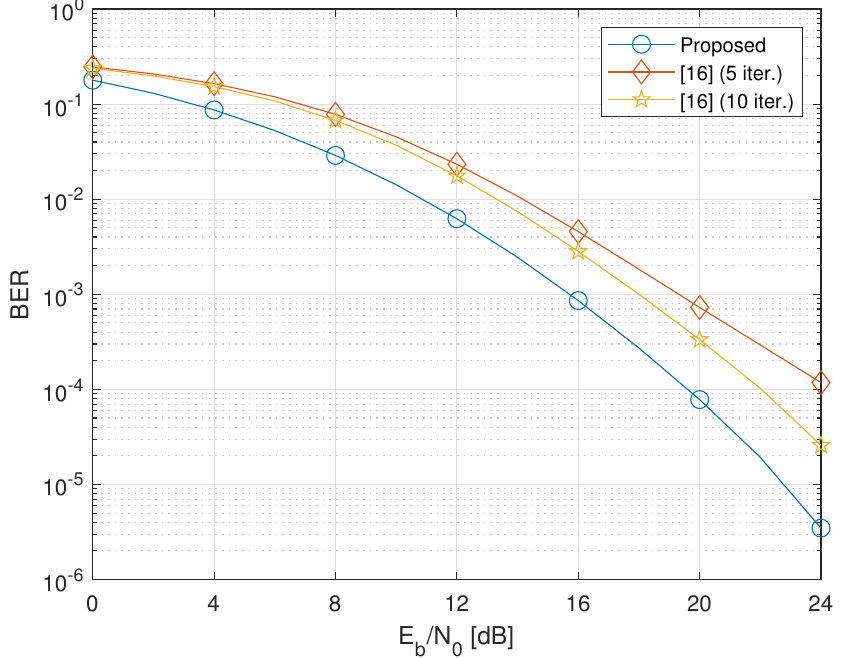
Figure 3. BER versus E b / N 0 of the proposed design versus the iterative method of Reference [16] ( N C =